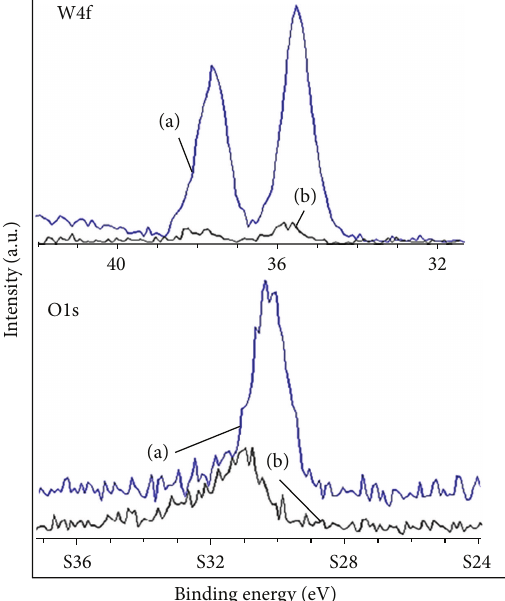
Figure 9: XPS spectra of the O1s and W4f in (a) WO 3 nanoparticle and (b) WO 3 -Ppy nanocomposite.